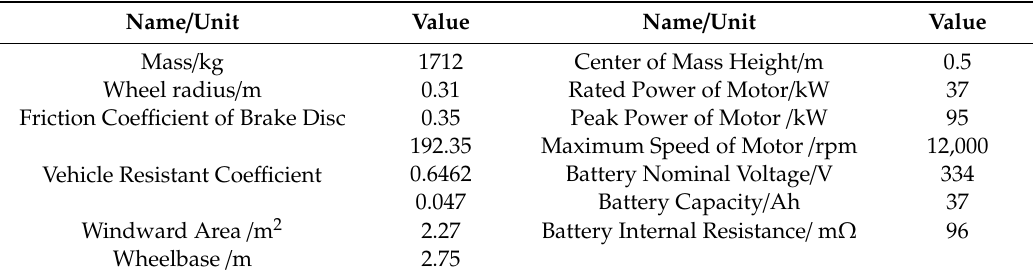
Table 1. Parameters of Vehicle and Key